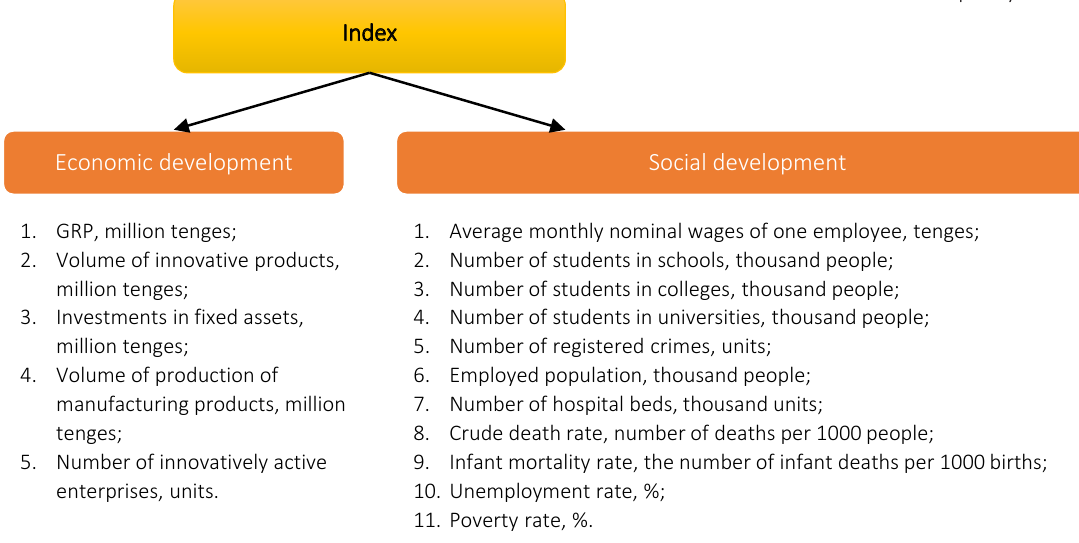
Figure 1. Parameters of social and economic development used to calculate the index